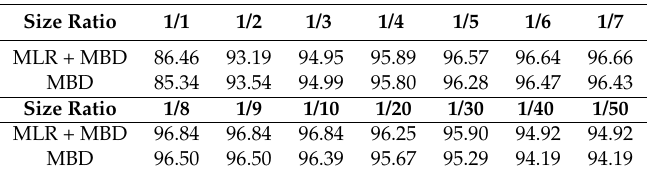
Table 11. Minority size analysis for MBD on MLII.